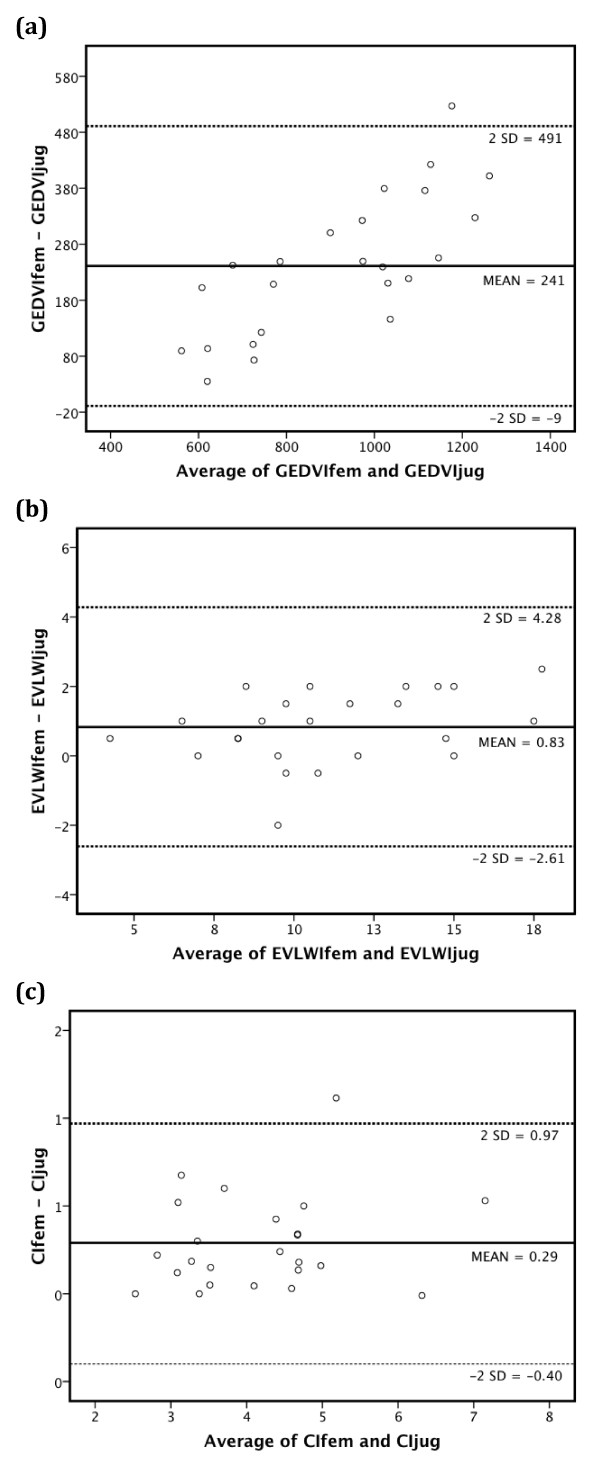
Transpulmonary thermodilution after femoral and jugular injection: Bland-Altman analysis. Bland-Altman analysis of global end-diastolic volume index (a), extra-vascular lung water index (b) and cardiac index (c) derived from transpulmonary thermodilution after femoral and jugular injection. GEDVIjug, jugular global end-diastolic volume index (mL/m2); GEDVIfem, femoral global end-diastolic volume index (mL/m2); EVLWIjug, jugular extra-vascular lung water index (mL/kg); EVLWIfem, femoral extra-vascular lung water index (mL/kg); CIjug, jugular cardiac index (L/min/m2); CIfem, femoral cardiac index (L/min/m2). The solid line indicates the mean difference between variables determined after femoral and jugular injection. The dotted lines indicate the limits of agreement (2*SD).